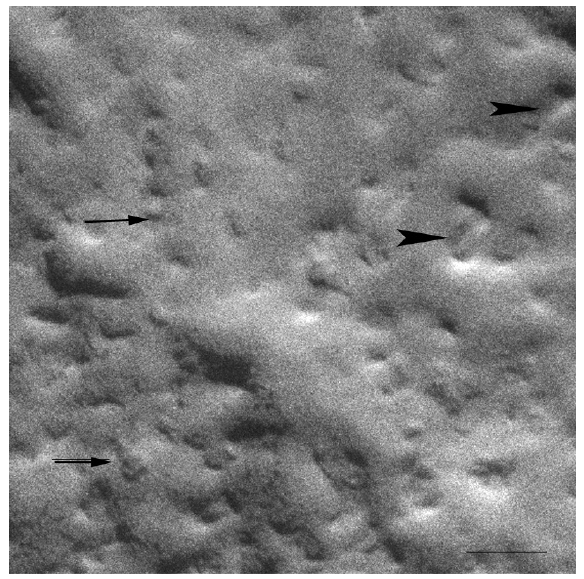
Figure 3. Electron micrograph of the S-q3.5 system at 20 °C. The arrows denote disks viewed face-on and the arrow heads denote disks viewed edge-on. Bar = 50